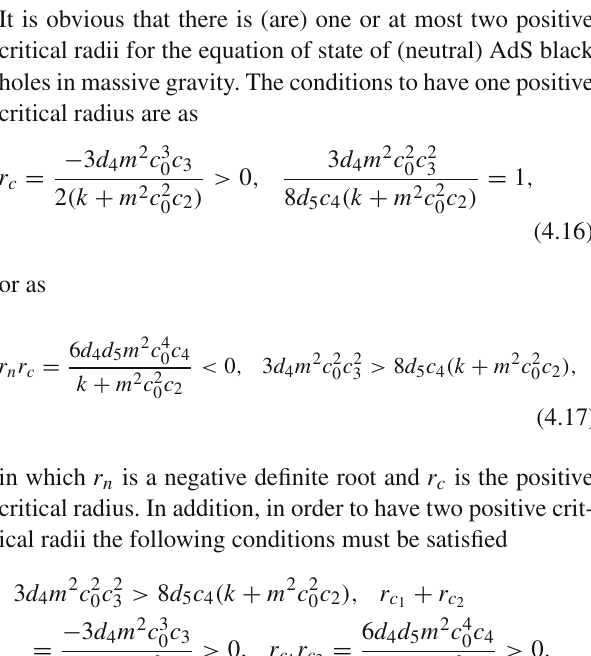
T = T c (dotted line) and T > T c (continuous lines). Middle and right panels: P < P c (dashed lines), P = P c (dotted lines) and P > P c (continuous